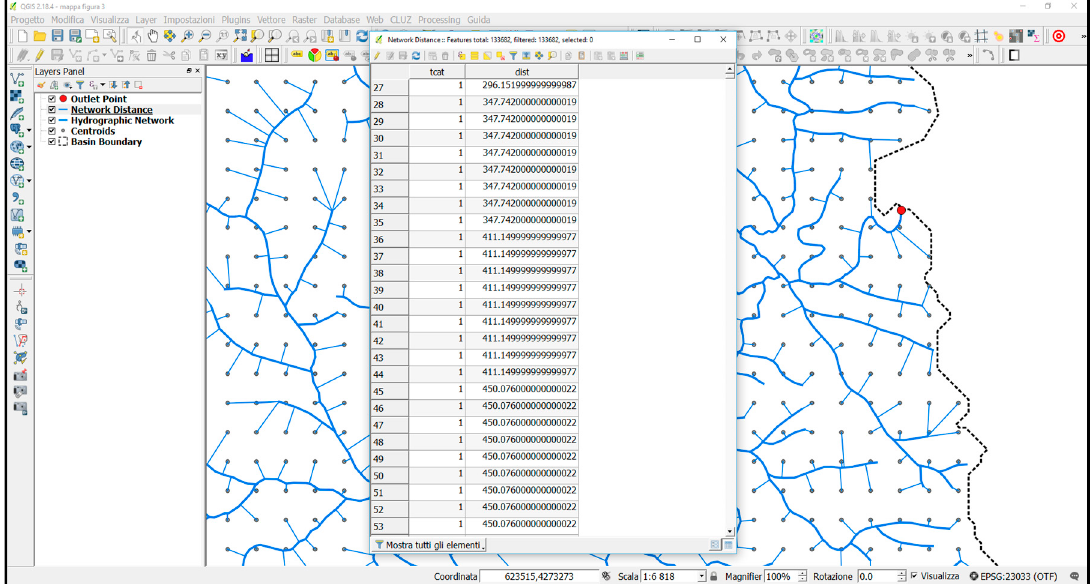
Figure 3. Result of the v.net.distance tool: the distances between centroids and outlet along the network arcs are computed and added to the attribute table.